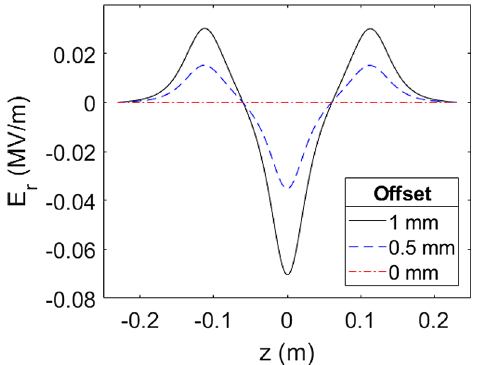
FIG. 13. Radial components of the electric fields in the cavities for different longitudinal offsets of 1 mm (solid line), 0.5 mm (dashed line), and 0 mm (on-crest acceleration) (dotted-dashed line), respectively.